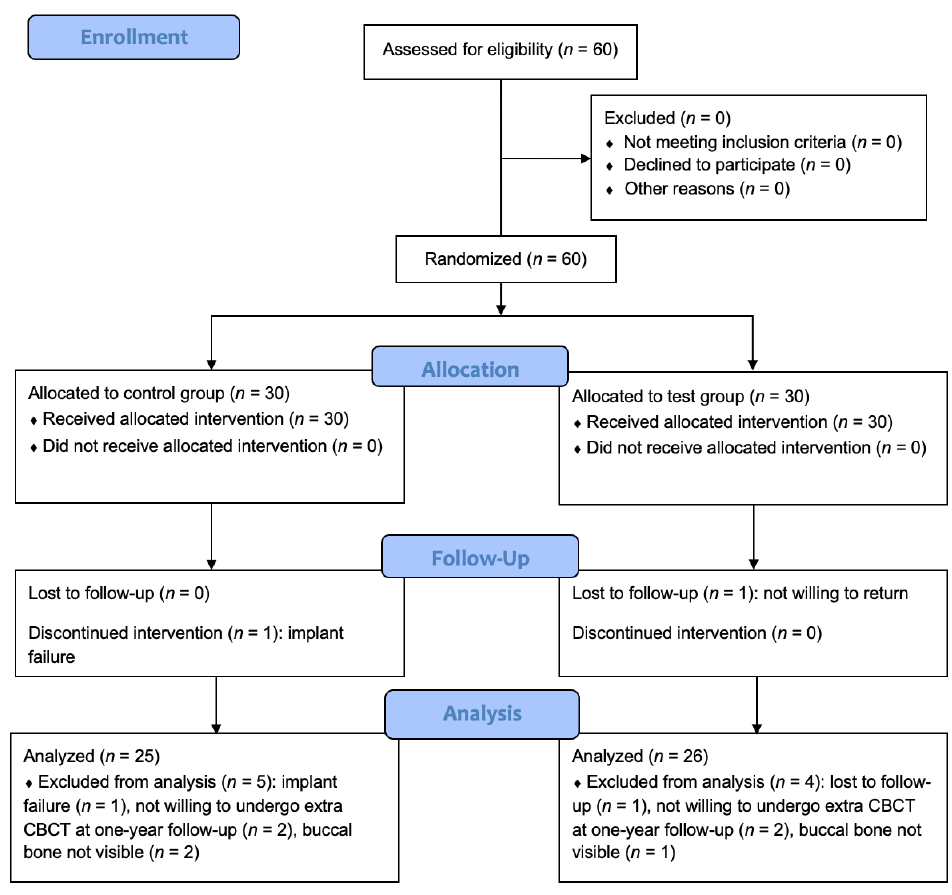
Figure 3. CONSORT flow diagram.